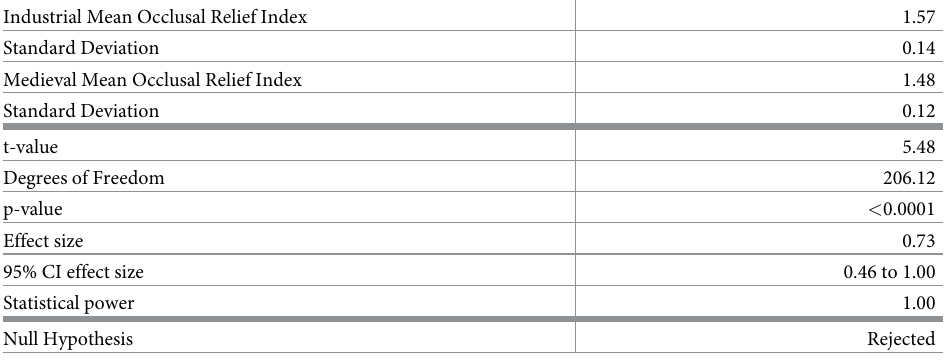
Table 8. Result of independent sample t-test examining the effect of period on Occlusal Relief Index (ORI) of the lower second